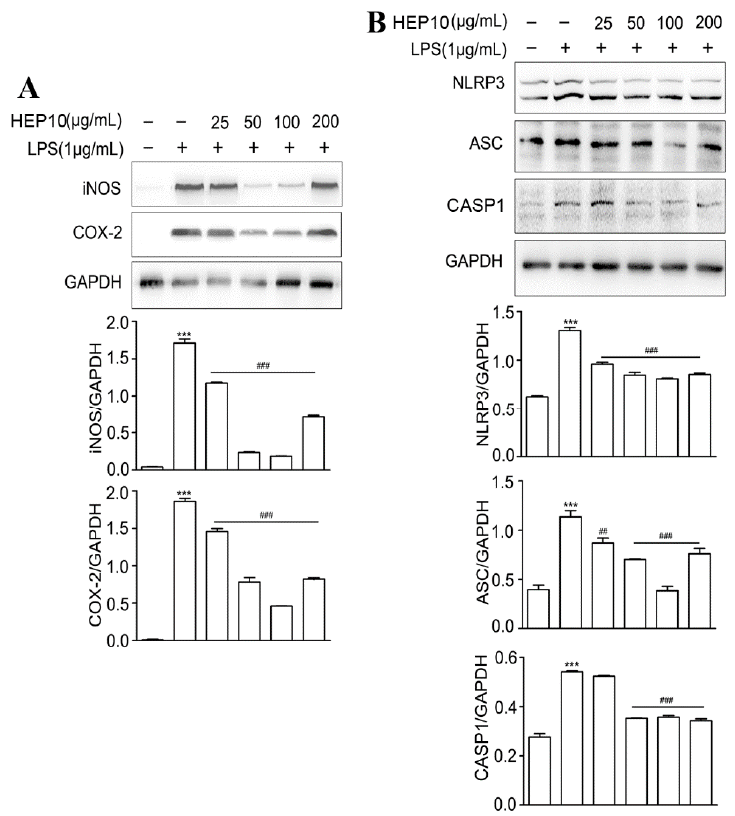
Figure 2. LPS-induced inflammation and NLRP3 inflammasome were downregulated in HEP10- treated RAW264.7 cells. HEP10 (25–200 µg/mL) treated for 1 h and then induced by LPS (1 µg/mL) for 2 h. ( A , B ) Western blot analysis of iNOS, COX-2, NLRP3, ASC, and CASP1 production in RAW264.7 cells. The data is presented as means ± SD ( n = 3), *** p < 0.001 vs. the CTL. ## p < 0.01 and ### p < 0.001 vs. the LPS treatment. The activation of NLRP3 inflammasomes results in the activation of CASP1 and subsequent cleavage of proinflammatory cytokines IL-1 β [3]. Productions of IL-1 β , NLRP3, ASC, and CASP1 indicate the activation of NLRP3 inflammasome [4]. LPS CASP1(Figure S3), whereas HEP10 (50–200 µg/mL) significantly downregulated their protein expressions (Figures S3 and 2B). Remarkably, the dose-dependent regulation of NLRP3 and ASC was observed within the HEP10 concentration range of 25–100 µg/mL. When the concentration was greater than 100 µ g/mL, the inhibition of NLRP3 and ASC was weaker than that of 100 µ g/mL HEP10. These results suggest that HEP10 (25–100 µg/mL) could inhibit NLRP3 inflammasome activation by suppressing the production of the abovementioned inflammasome components. 3.3.3. HEP10 Downregulated LPS-Induced NF- κ B, AKT, and MAPK Signaling In Vitro NF- κ B and AKT signaling pathways regulate gene transcription, protein synthesis, and cytokine production in macrophages [31,32]. As shown in Figure 3, there were higher protein levels of p-p65, I κ B- α , and Akt after LPS stimulation compared with the CTL group. HEP10 (50–200 µg/mL) treatment significantly inhibited LPS-induced p-p65, p- I κ B, and p-Akt expression. The ERK, JNK, and p38 are conventional mitogen-activated protein kinases (MAPKs) that participate in a number of fundamental cellular processes such as growth, differentiation, apoptosis, and inflammation [33]. Western blot analysis